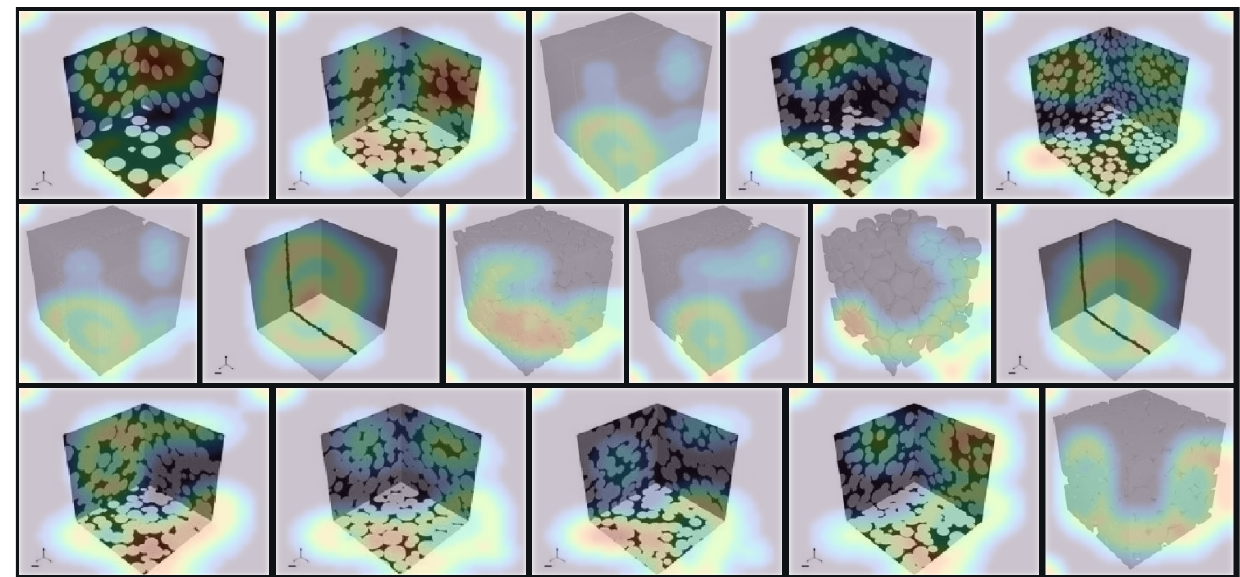
Energies 2022 , 15 , x FOR PEER REVIEW Figure 14. Activation maps visualizing paths (supervised). Figure 14. Activation maps visualizing paths (supervised).